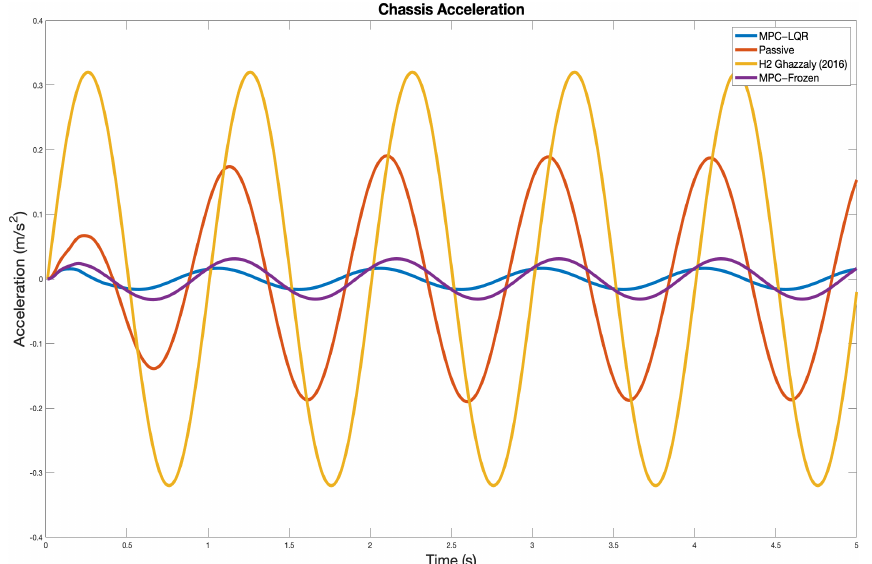
Figure 12. Chassis Acceleration—Sinusoidal disturbance (Blue—MPC-LQR, Red—Passive, Yellow— H2,